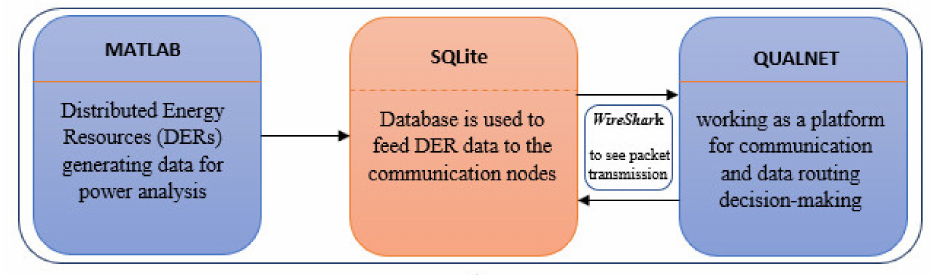
Figure 7. Interconnection of the software modules used for simulation of the grid network.